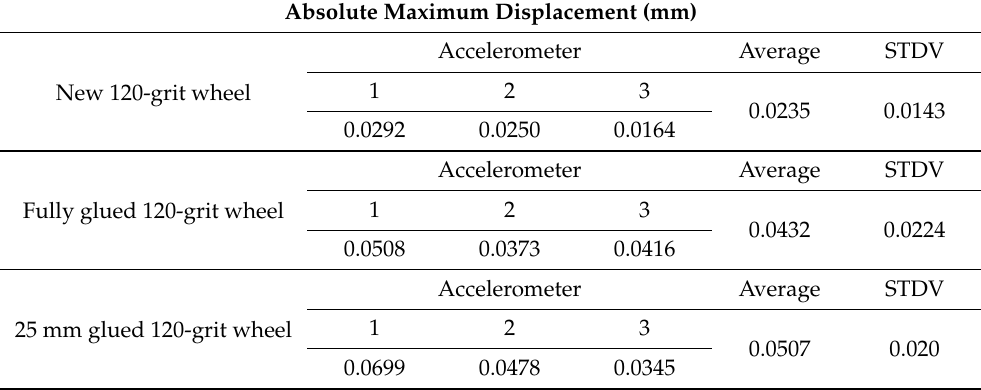
Table 3. Average and maximum displacement results of the 120-grit medium-grade wheels after 60 impact hammer tests.